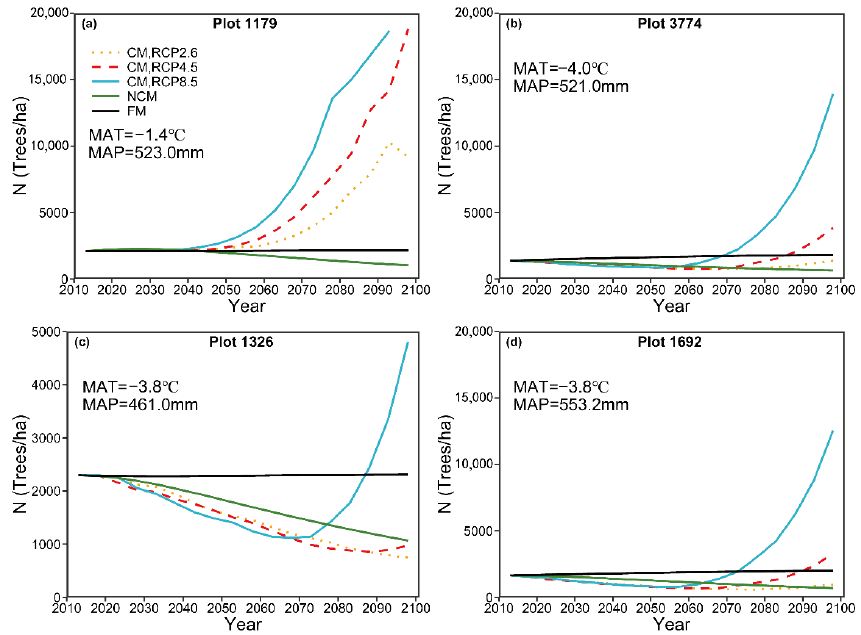
Figure 6. Long-term prediction of tree numbers by the climate-sensitive model (CM) under 3 different RCPs, the variable transition model which did not expect climate change (NCM), and the fixed-parameter model (FM), using NFI plot numbers 1179, 3774, 1326, and 1692. The value of the MAT is the mean annual temperature between 2013 and 2018 and MAP represents the mean annual precipitation of the same period.